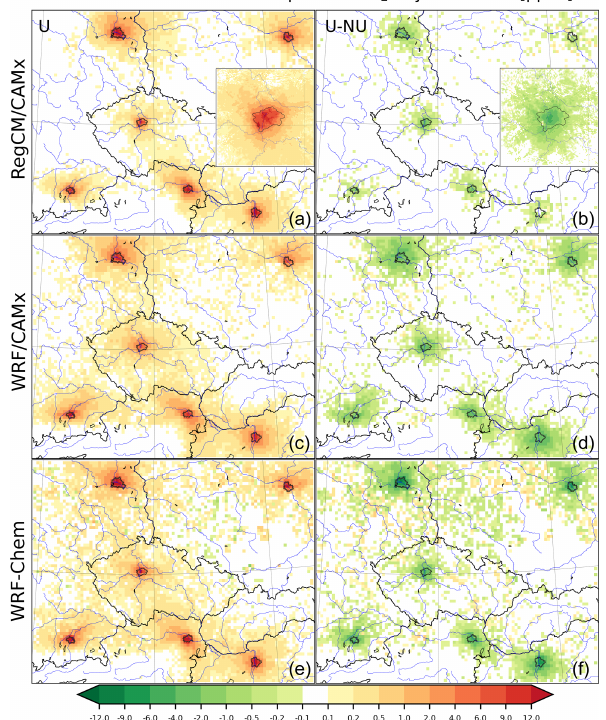
Figure 12. The impact of urban emissions (UEI) for selected cities (Berlin, Budapest, Munich, Prague, Vienna and Warsaw) on the 95th percentile of the daily mean NO 2 concentrations for the three models (as rows) for the 2015–2016 period: the left column shows the absolute UEI for the URBAN case, while the right column de- notes the (cid:49) UEI, i.e., the difference between the UEI for the UR- BAN and NOURBAN cases. Results from the 1km × 1km experi- ment are plotted within (a) and (b) . Units in parts per billion volume (ppbv).